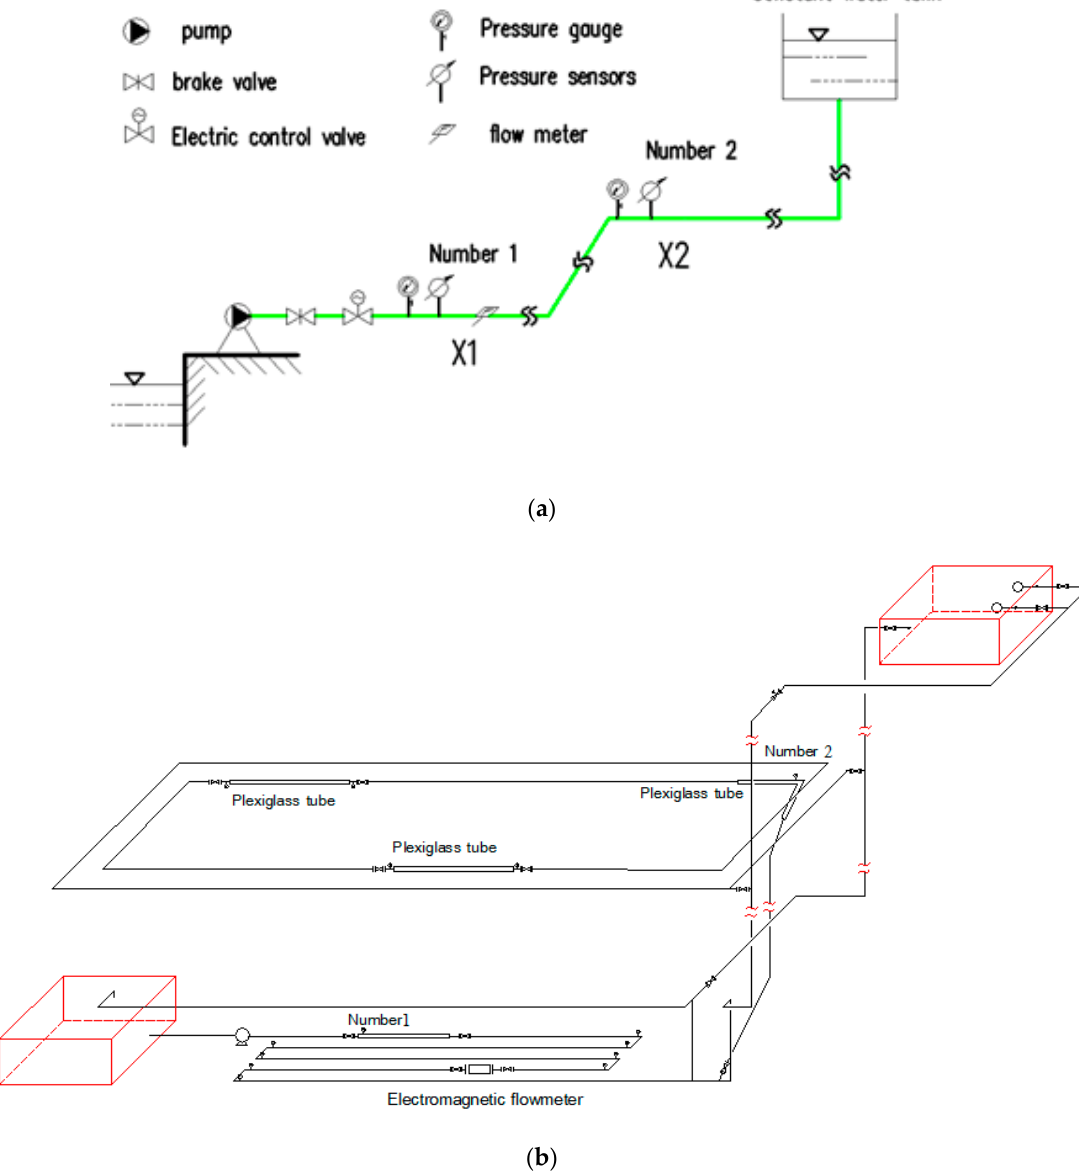
Figure 2. Experimental design: ( a ) schematic diagram of the experimental device; ( b ) diagram of the experimental pipeline system.